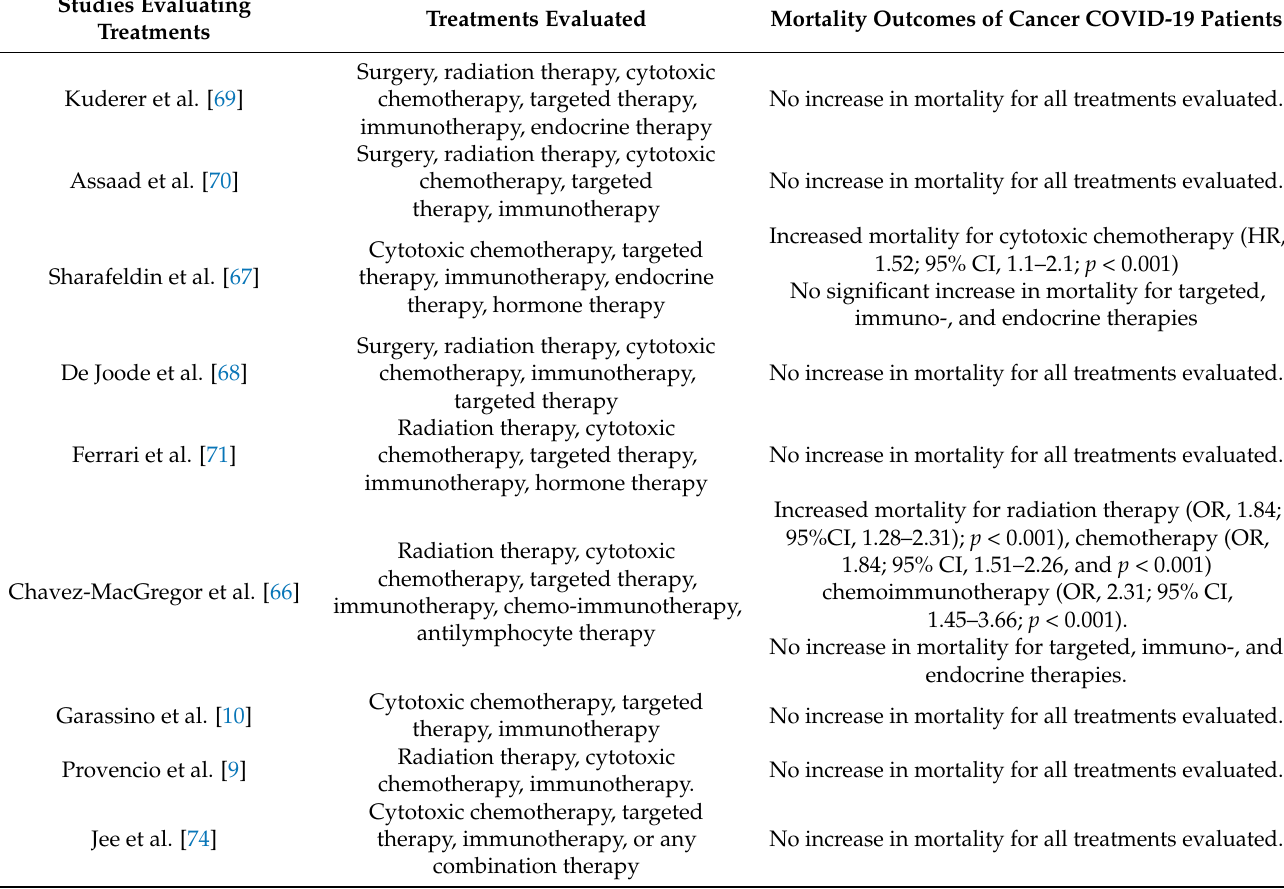
Table 2. Summary of recent anticancer treatment affecting COVID-19